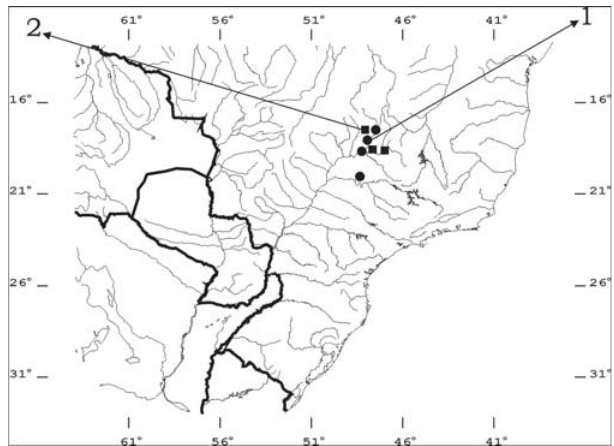
Fig. 4. Map of southeastern South America showing geo- graphic distribution and type-locality (numbers) of Hyposto- mus heraldoi (dots; 1 = rio Pirapitinga), and H. denticulatus (squares; 2 = rio do